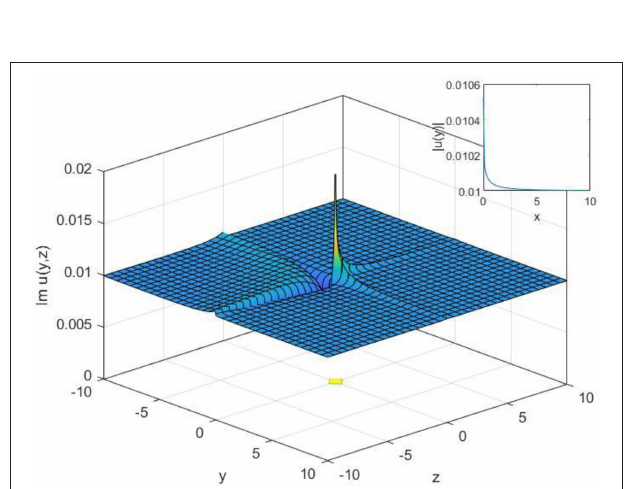
FIGURE 2 | 2-D, 3-D, and contour plot of singular soliton solution Equation (21) when λ z 2 for 2-D. =